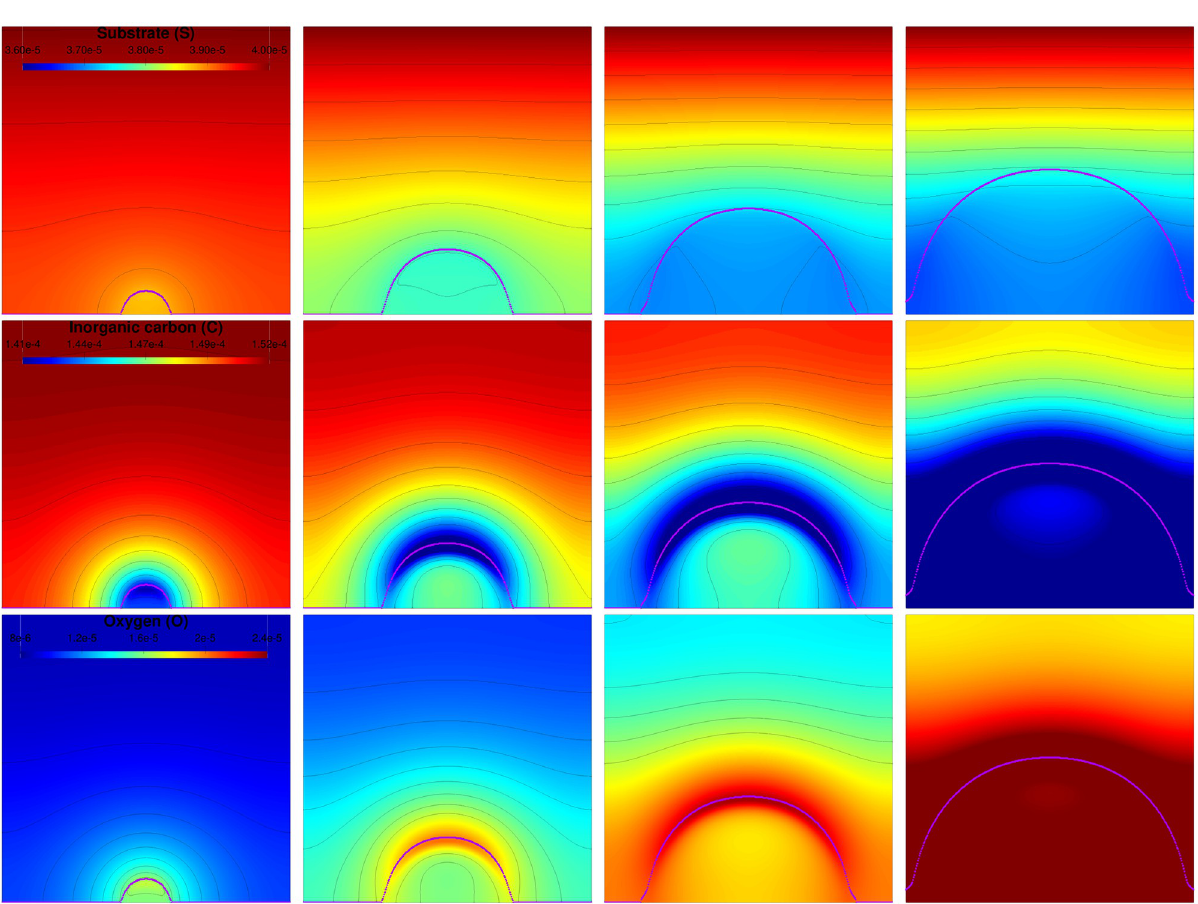
Fig 3. Distribution of the dissolved components for a biofilm starting from a single spot colony. The inorganic nitrogen concentration (first line), inorganic carbon distribution (second line) and oxygen distribution (third line) are represented at times t = 5, t = 15, t = 25 and t = 35 days (from left to right). The purple dotted line represents the biofilm front defined as the largest value for the biofilm gradient.